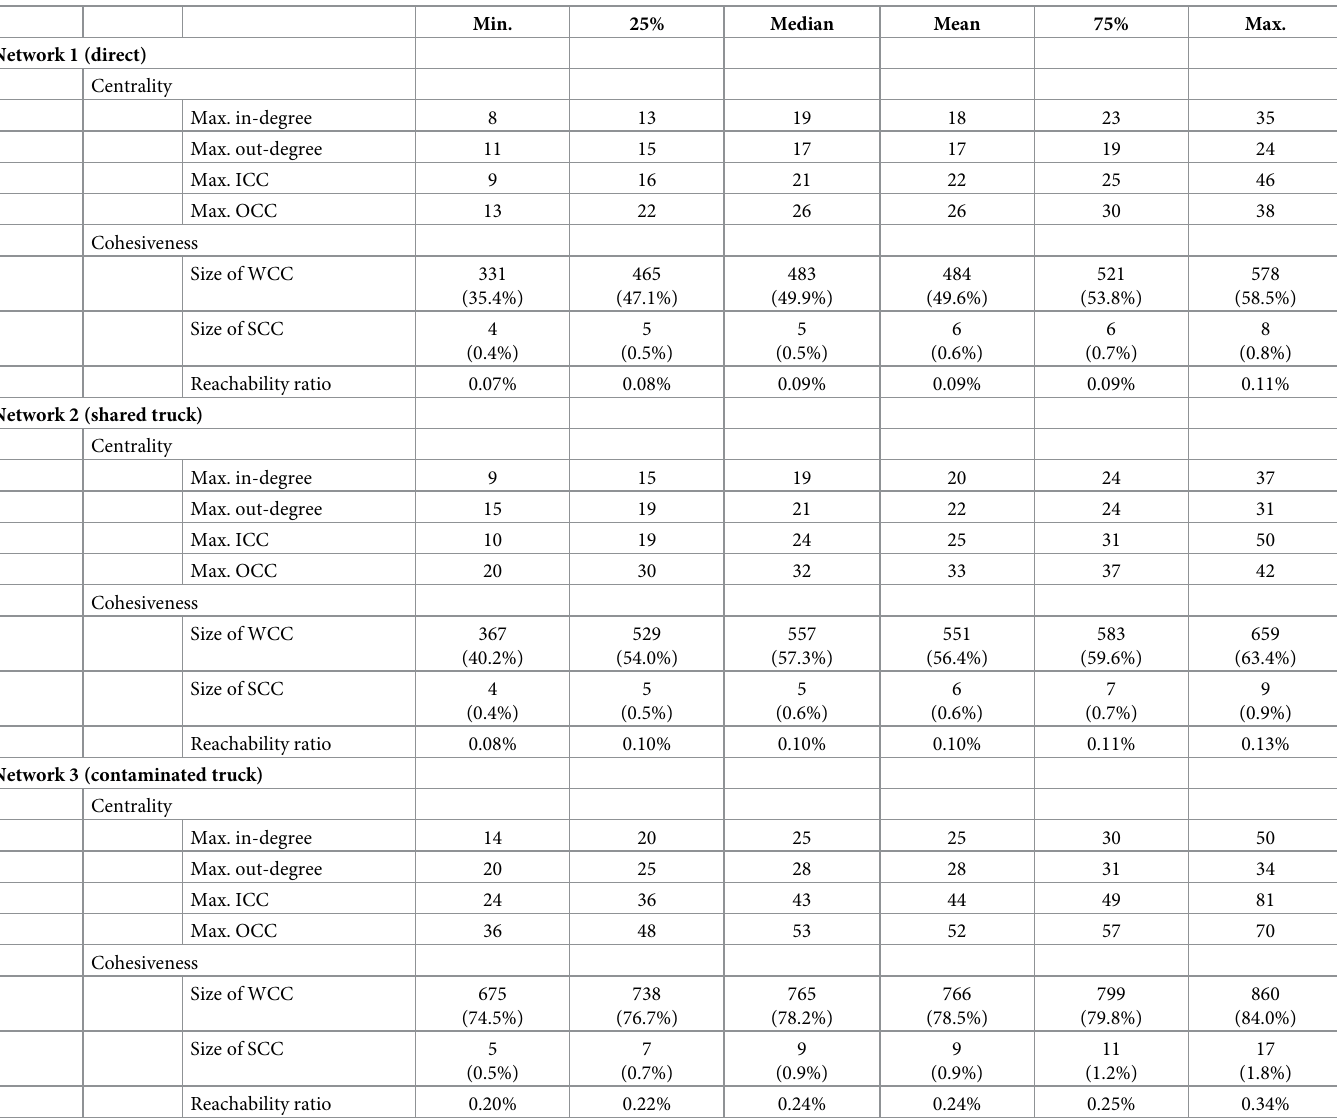
Table 4. Results for centrality and cohesiveness measures over all 48 monthly networks. The networks are based on the data from one transport company (TRP).